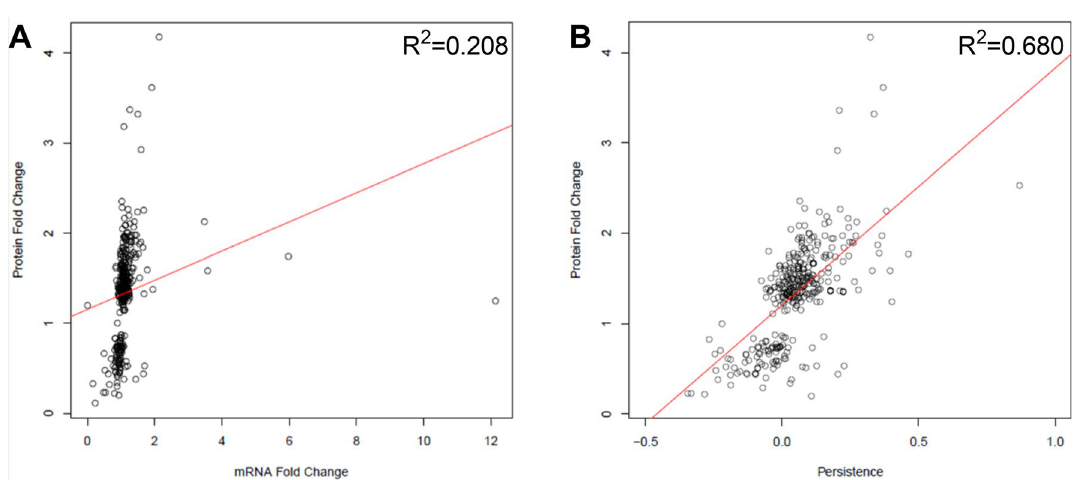
Figure 5. Persistence better predicts protein fold change in SCZ than mRNA fold change alone in the DISC1 dataset. ( A ) Correlation between protein and mRNA fold change (R 2 = 0.208). ( B ) Correlation between protein fold change and persistence scores (R 2 = 0.68). This improved correlation suggests that persistence can be predictive of protein abundance but room for improvement exists in the calculation. Figures produced using R base graphics 45